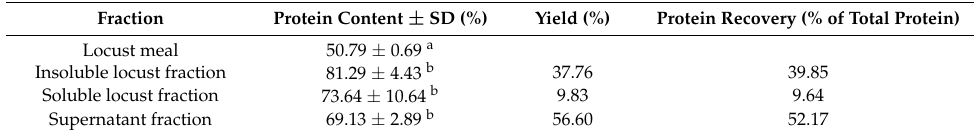
Protein contents (%) with different letters within column are significantly different at p < 0.05 ( n = 3). Yield and protein recovery percentages, n = 1. Locust meal (LM); Soluble locust fraction (SLF); Supernatant fraction (SF); Insoluble locust fraction